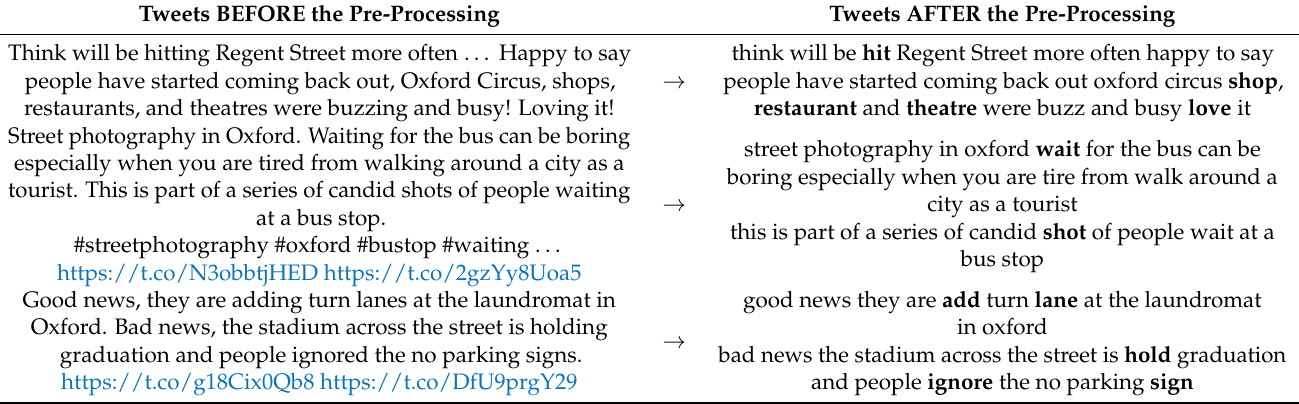
Table 1. Example of tweets before and after the pre-processing.